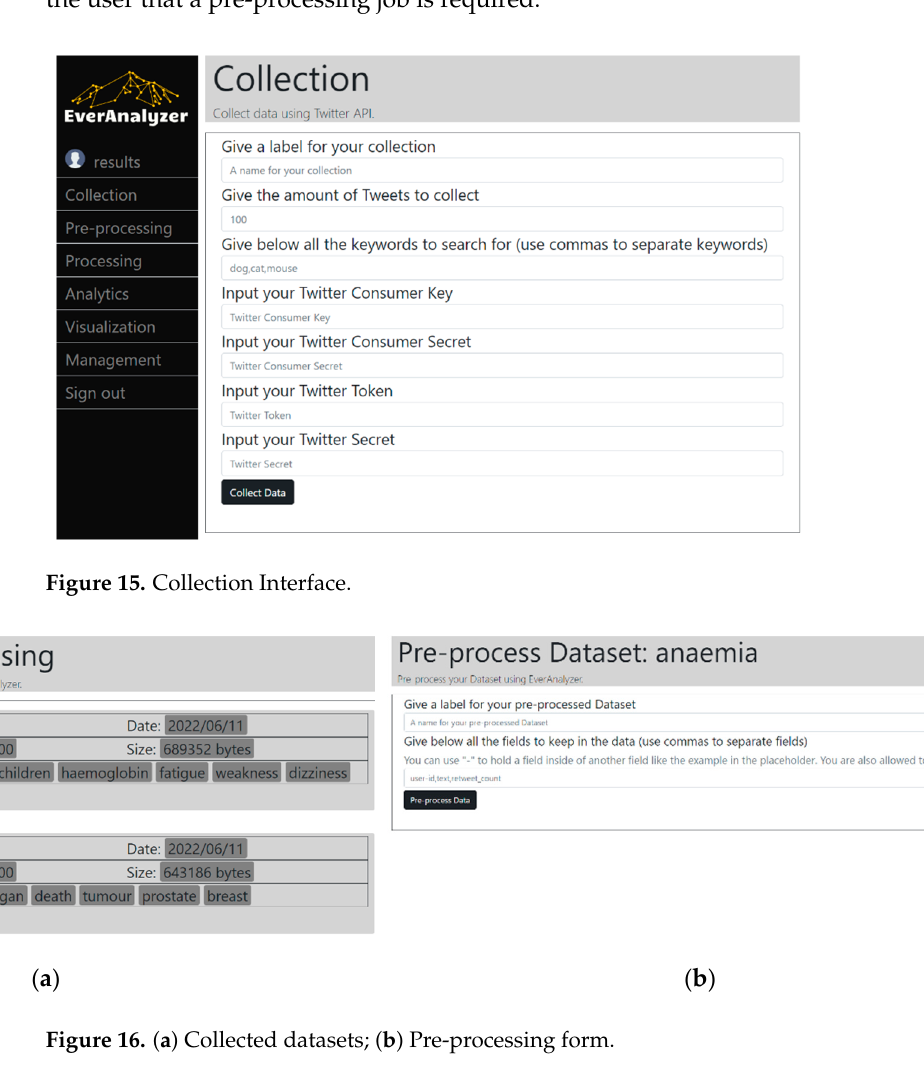
Figure 14. Homepage Interface.